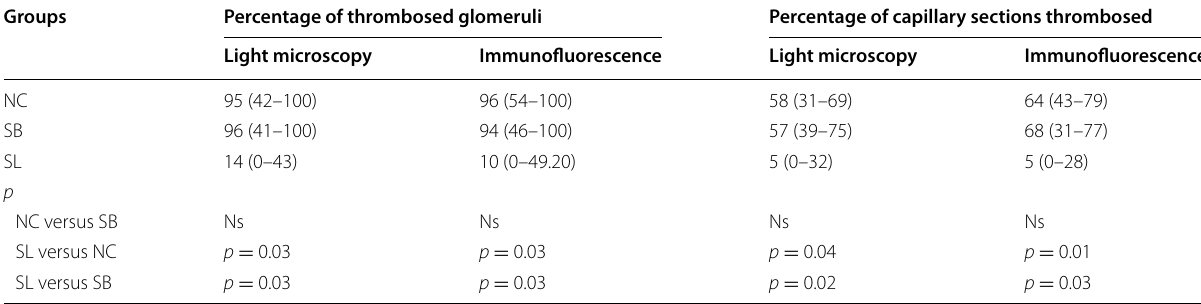
Fig. 2 Histological comparison of NC and SL groups samples. Light microscopy (Masson’s trichrome, magnification rescence study with polyclonal antifibrinogen antibody ( b ) of a kidney section. In NC group sample, glomeruli showed signs of oedema uniformly, with glomerular capillary thrombosis well estimated by immunofluorescence